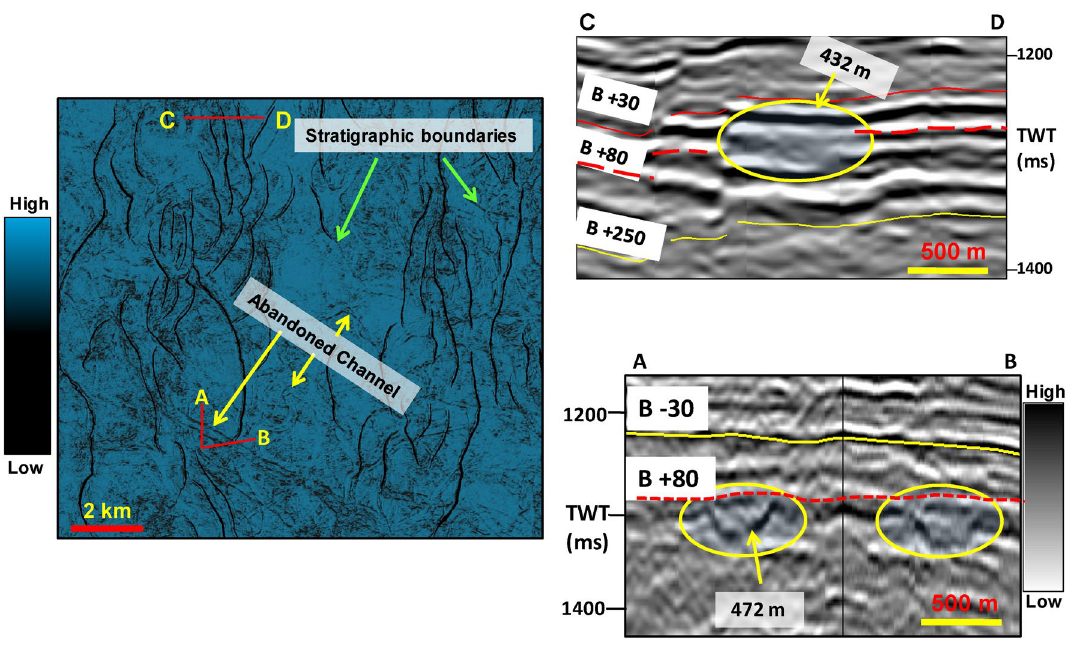
Fig. 8 The cross sections of identified features on semblance map of horizon B+80 clearly show channels of various dimensions in the vertical section Fig. 9 Dip-steered similarity slice of horizon D showing channel features which were not evident in semblance slice. Cross section along A–B shows the presence of channel in verti- cal